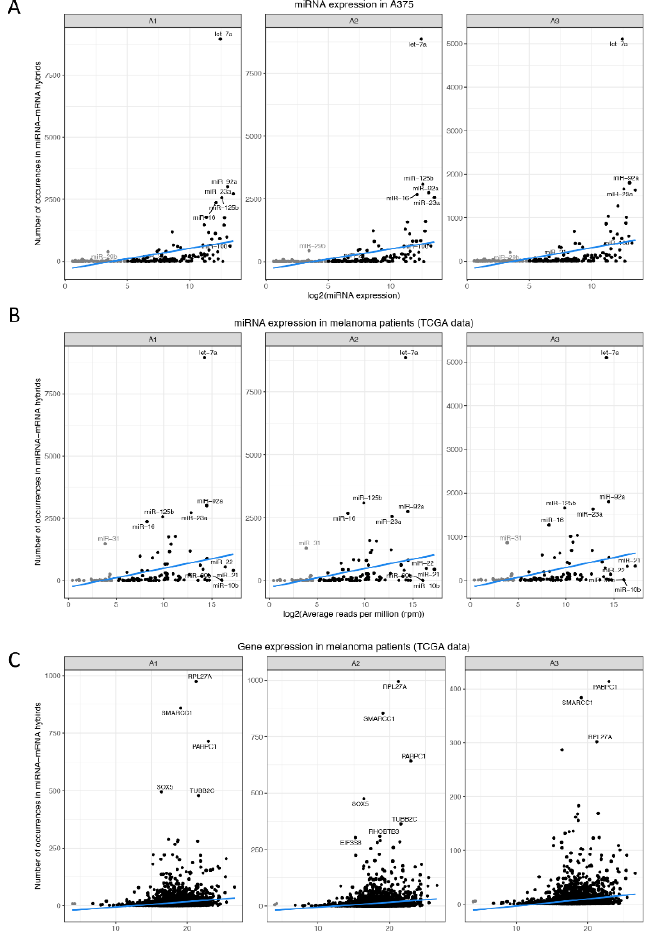
Figure 4. Correlation between hybrid number and miRNA or mRNA expression levels. Number of miRNA occurrence frequency in miRNA-mRNA hybrids of the biological replicates (A1, A2, and A3) of the melanoma cell line A375 compared to ( A ) log2 miRNA expression levels in A375 [8] and ( B ) log2 average reads per million (rpm) in melanoma patient samples (TCGA 2015 data). ( C ) Number of mRNA occurrence frequency in miRNA-mRNA hybrids compared to log2 gene expression (mRNA) levels in melanoma patient samples (TCGA2015